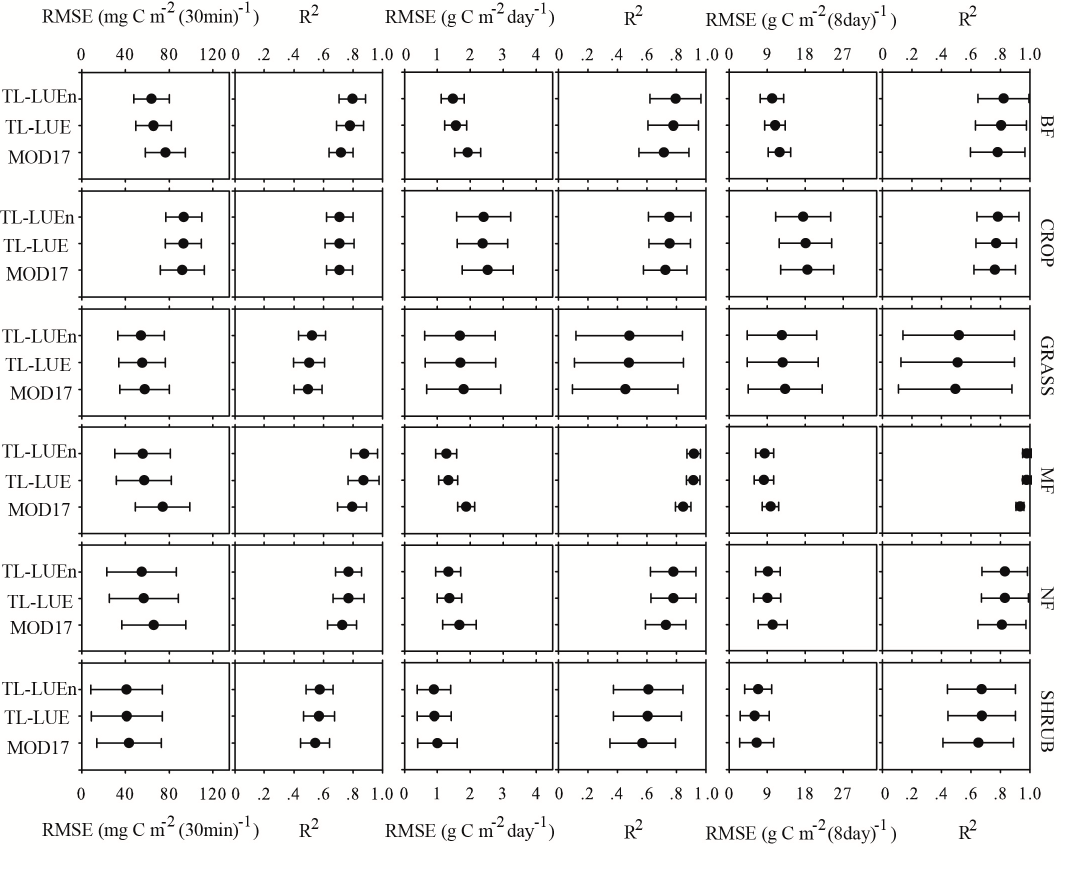
Figure 3. Average RMSE and R 2 of GPP simulated using calibrated TL-LUEn, TL-LUE and MOD17 in the calibration site-years at half-hourly (the first and second columns), daily (the third and fourth columns), and 8-day (the last two columns) scales for individual vegetation types. Note: Broadleaf forest (BF); Mixed forest (MF); Needleleaf forest (NF); Crop (CROP); Grass (GRASS); Shrub (SHRUB). Solid black circles are the means and horizontal error bars denote standard